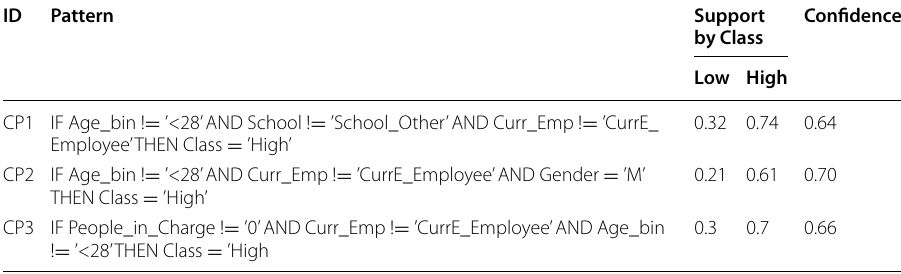
Table 10 PBC4cip three contrast patterns for current income high